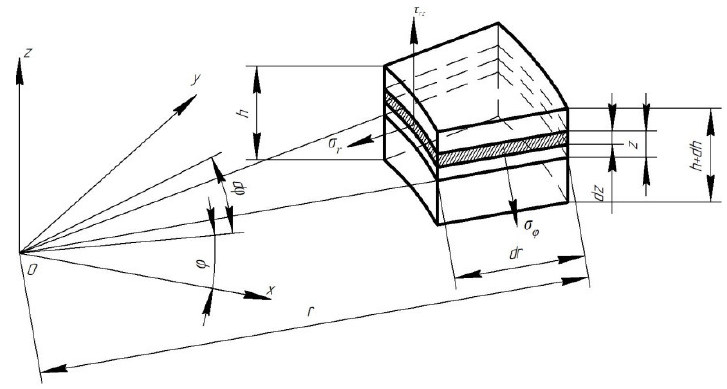
Figure 8. Plate element.